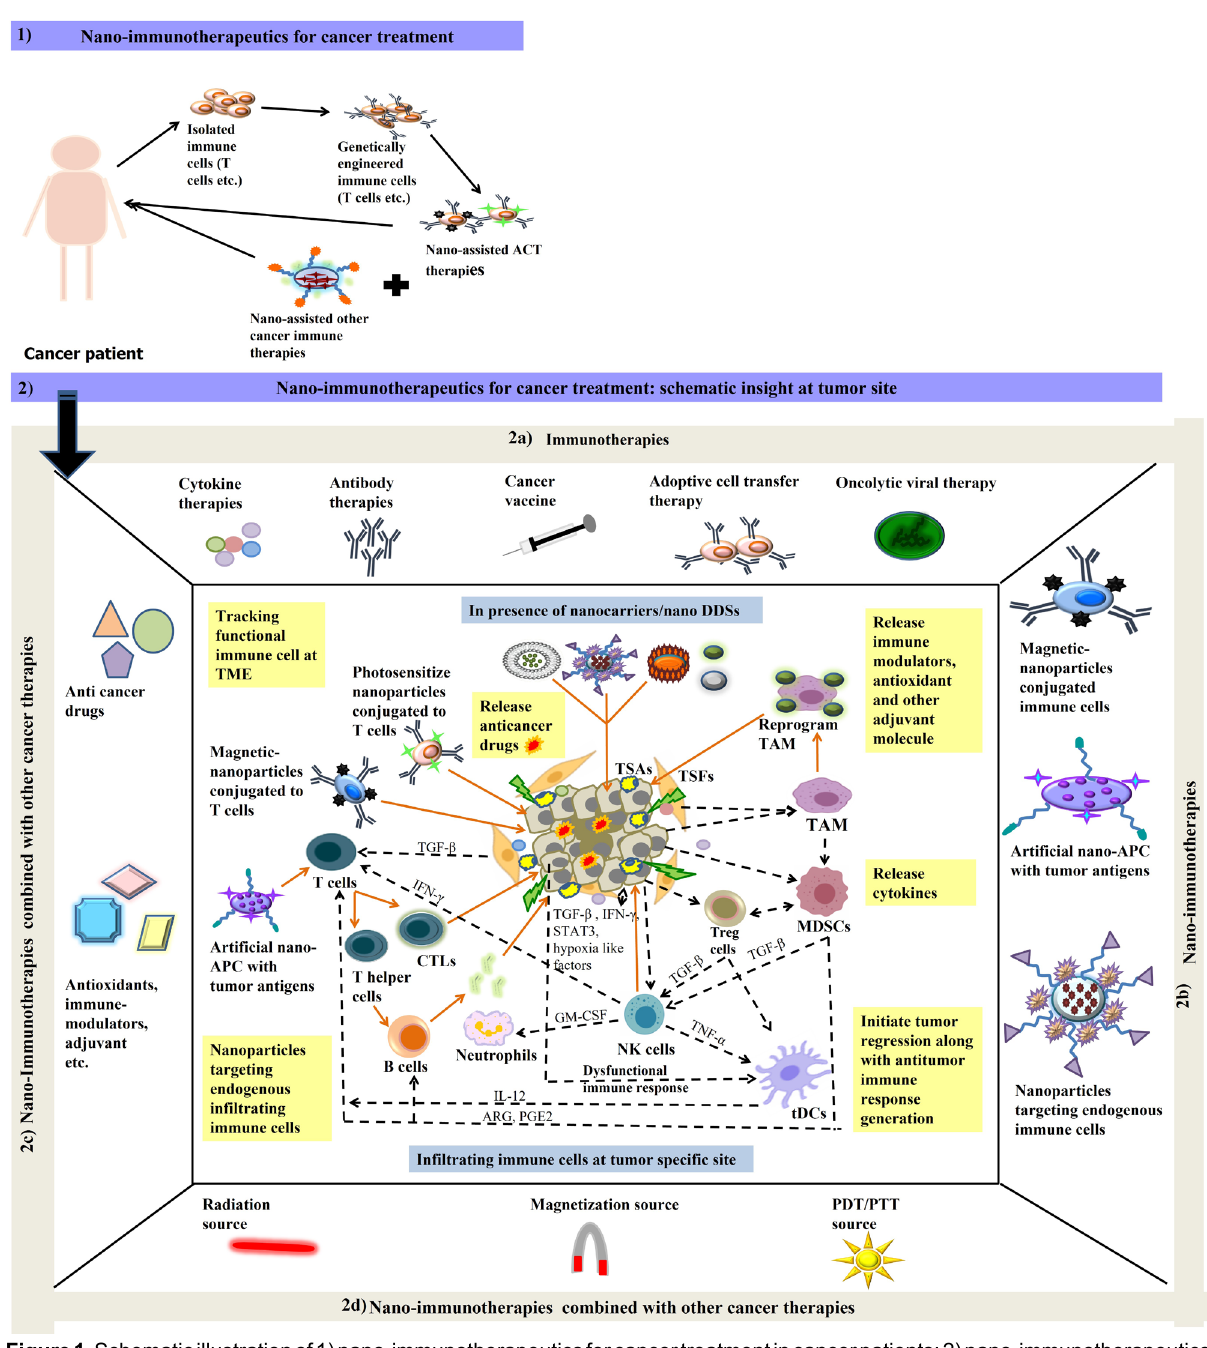
immune modulating compounds and adjuvant molecules encapsulated in nano-drug delivery systems (DDSs) for cancer treatment; 2d) represent different combination approaches additional to nano-immunotherapies in form of radiation, photodynamic therapy/ photothermal therapy (PDT/PTT) or magnetized source for better cancer management. Dash lines in black color represent the existing crosstalk amongst different cells (cancer cells: TSFs, TSAs etc.); immune cells (TANs, TAMs, MDSCs, Tregs, T cells, B cells, NK cells etc.) at TME. Lines in orange color represent the probable route of action for nano-assisted immune